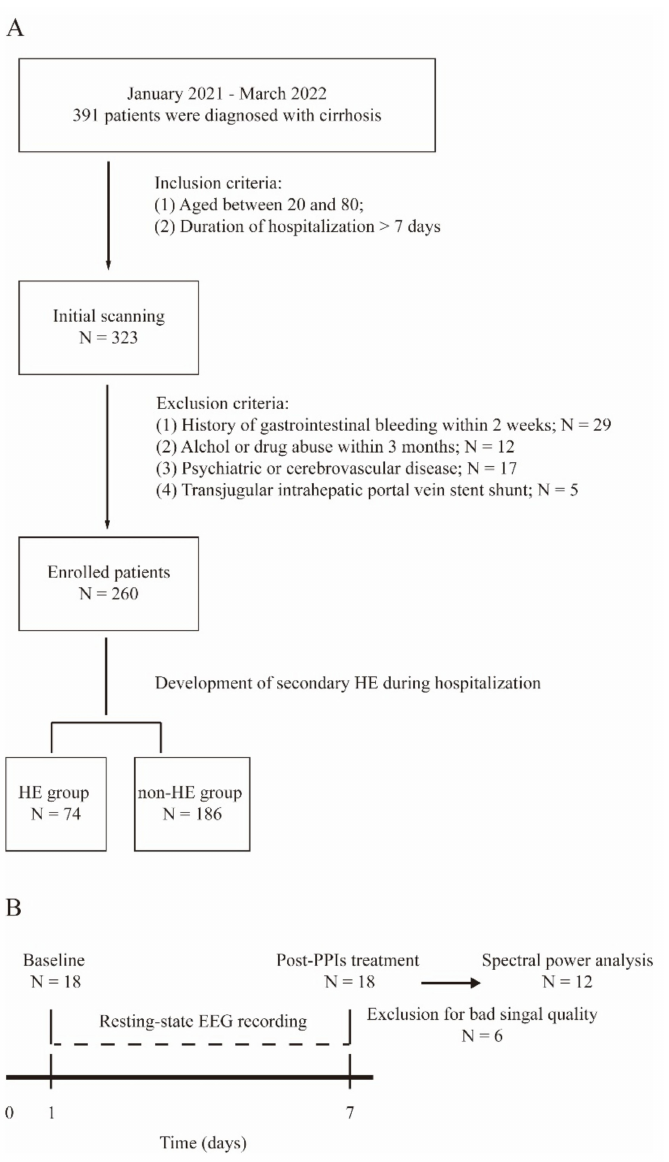
Figure 1. Study protocol for the Experiment One and Two. ( A ) Flow chart of patient selection for the first part of the study. ( B ) Schematic of EEG recording protocol for the second